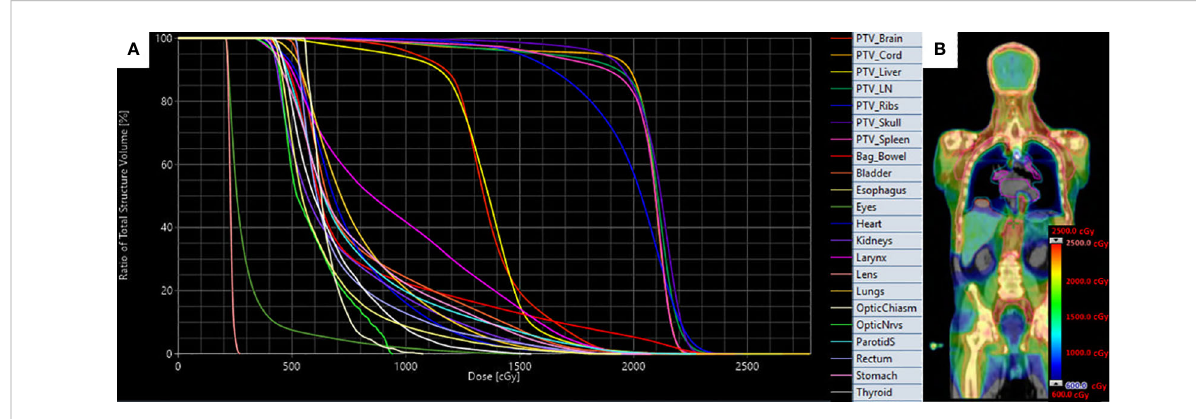
FIGURE 2 Target and organ-at-risk dose volume histograms (A) and three-dimensional dose distribution (B) of patient treated with VMAT TMLI to 20